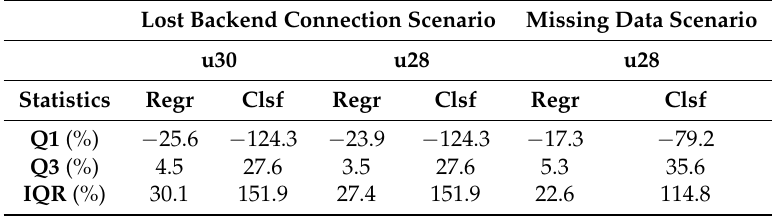
Figure 8. Results displayed considering problem-specific energetic perspective (EP). Therefore, errors shown are percentage errors in predicted ED. Panels ( a , b ) show evaluations for the LBCS and a prediction only based on regression and classification models. These evaluations use the model trained on the u28 geohash region and are calculated on the u30 (a) and the u28 (b) region. Panel ( c ) shows results for training and evaluation in u28 region. Accordingly, the regression and classification model predicts only 30% of the segments. Table 5. Spread in errors for different scenarios from the energetic point of view displaying the interquartile range (IQR) and its borders: The 25%-percentile (Q1) and the 75%-percentile